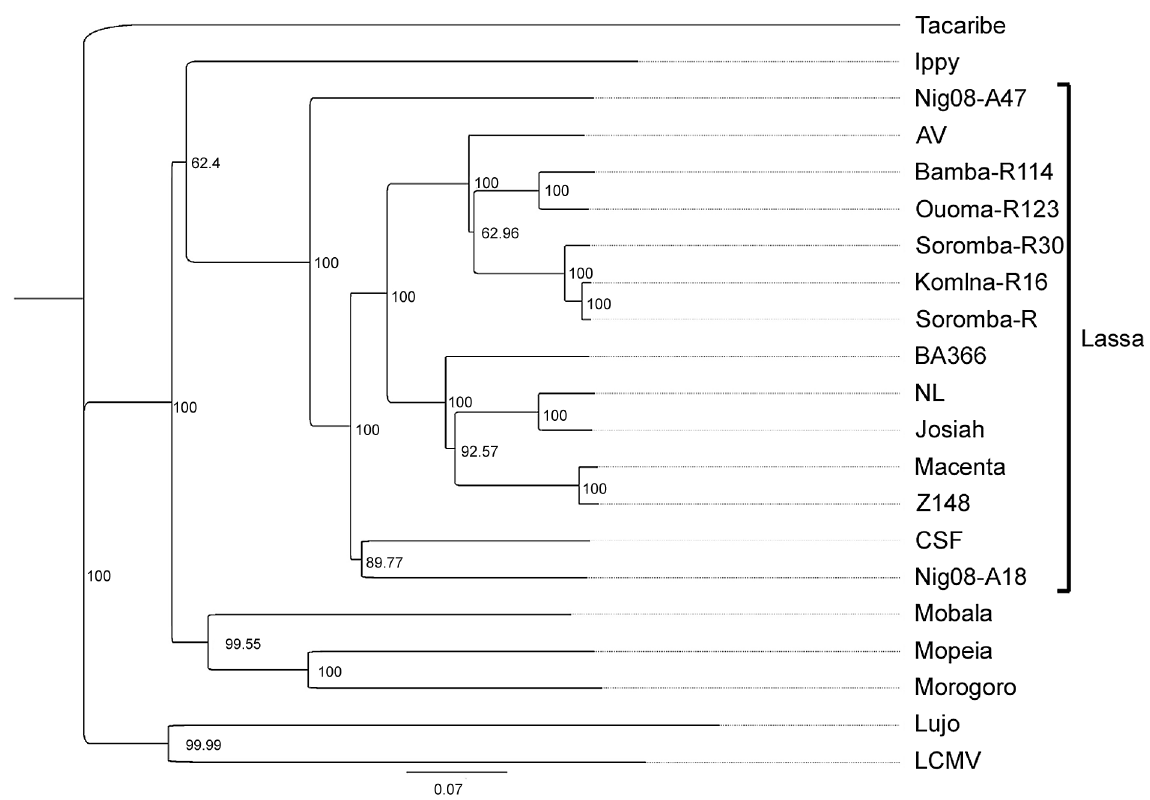
Figure 4. Phylogenetic analysis was conducted on full-length sequences for the polymerase using the Jukes-Cantor Neighbor- joining method with 10,000 bootstrap replicates. Sequences from the five Malian isolates were compared to the following arenavirus sequences: Tacaribe (NC_004292), Lujo (NC_012777), Lymphocytic choriomeningitis virus (LCMV, strain Armstrong, J04331), Ippy (NC_007906), Mobala (NC_007904), Morogoro (NC_013058), Mopeia (NC_006574) and Lassa virus strains Josiah (NC_004297), CSF (AY179174), NL (AY179172), AV (AY179171), Z148 (AY628204), Macenta (AY628200), BA366 (GU979513), Nig08-A18 (GU481071), Nig08-A47 (GU481079).